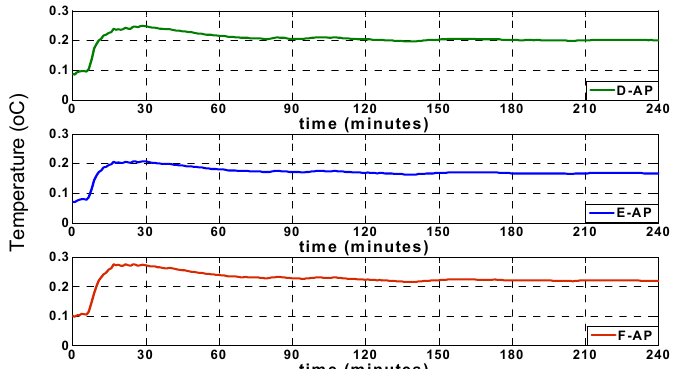
Figure 11. Performance of different approximation platforms